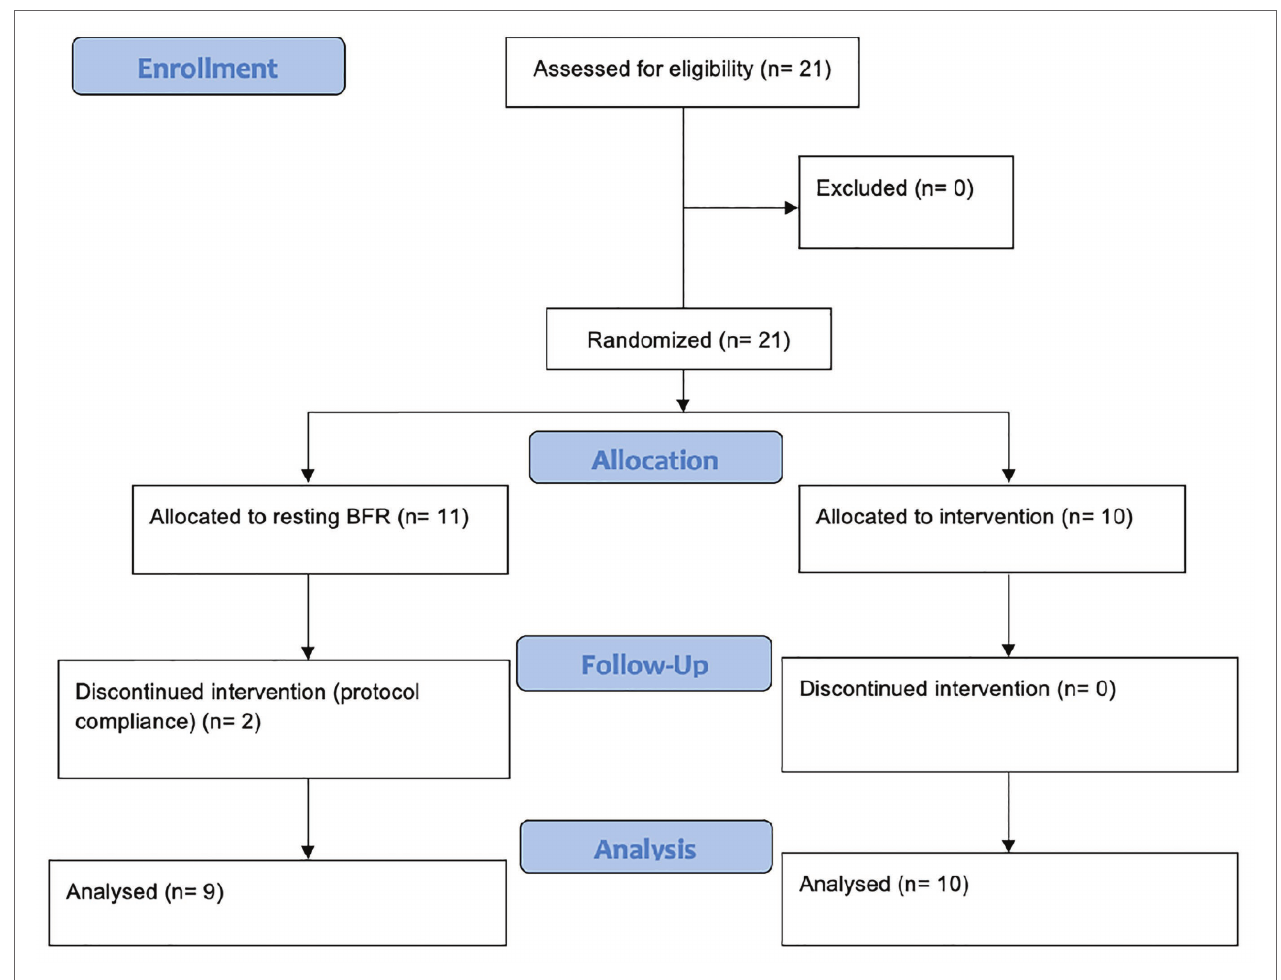
FIGURE 1 | Flow chart of study conduction (Moher et al.,